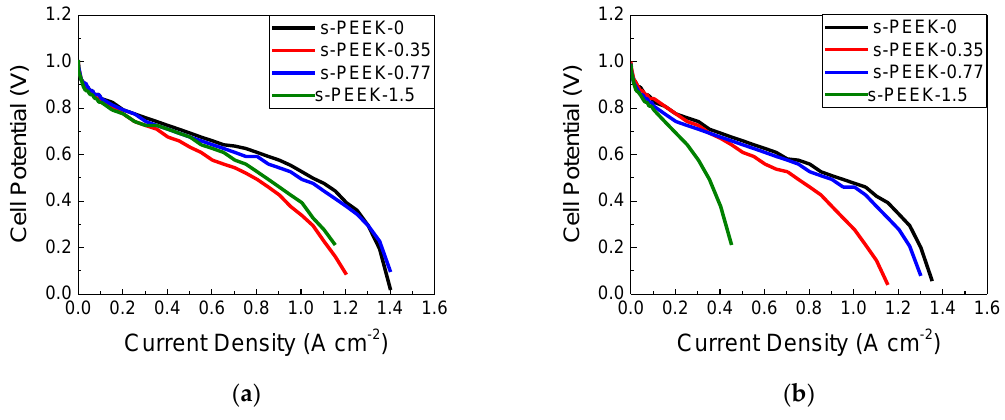
Figure 6. Polarization curves at 80 °C and different relative humidity (RH) levels: ( a ) 100% and ( b ) 75%. Table 4. Electrochemical parameters for the membranes under